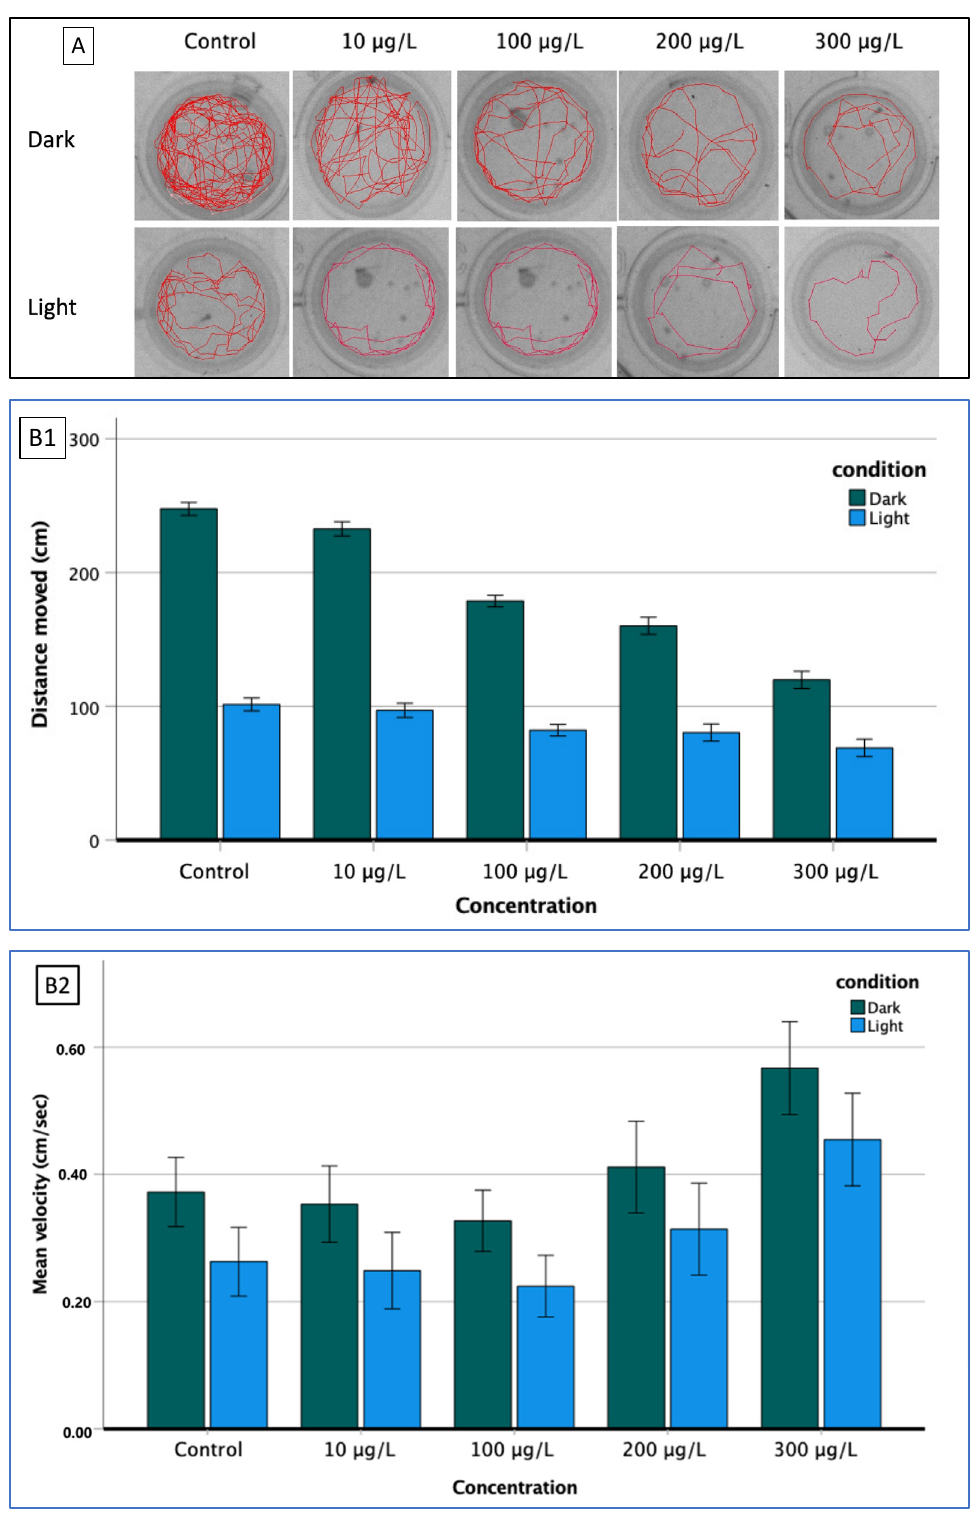
Figure 4. Locomotor activity of zebrafish embryos under the effect of 2,6-DCBQ-OH. ( A ) This represents cumulative track plots of the position of zebrafish embryos exposed to various concentrations of 2,6-DCBQ-OH under dark and light conditions. ( B ) This represents means of total distance moved ( B1 ) and means of velocity ( B2 ) ( n = 44) of embryos at 144 hpf during a 30 min period of behavioral recording. Embryos were placed in individual wells of a flat-bottom 48-well plate and acclimated to the recording chamber before tracking began. Data shown are sums of 30 min (average ± standard error). Error bars shows standard error of the mean (SEM).